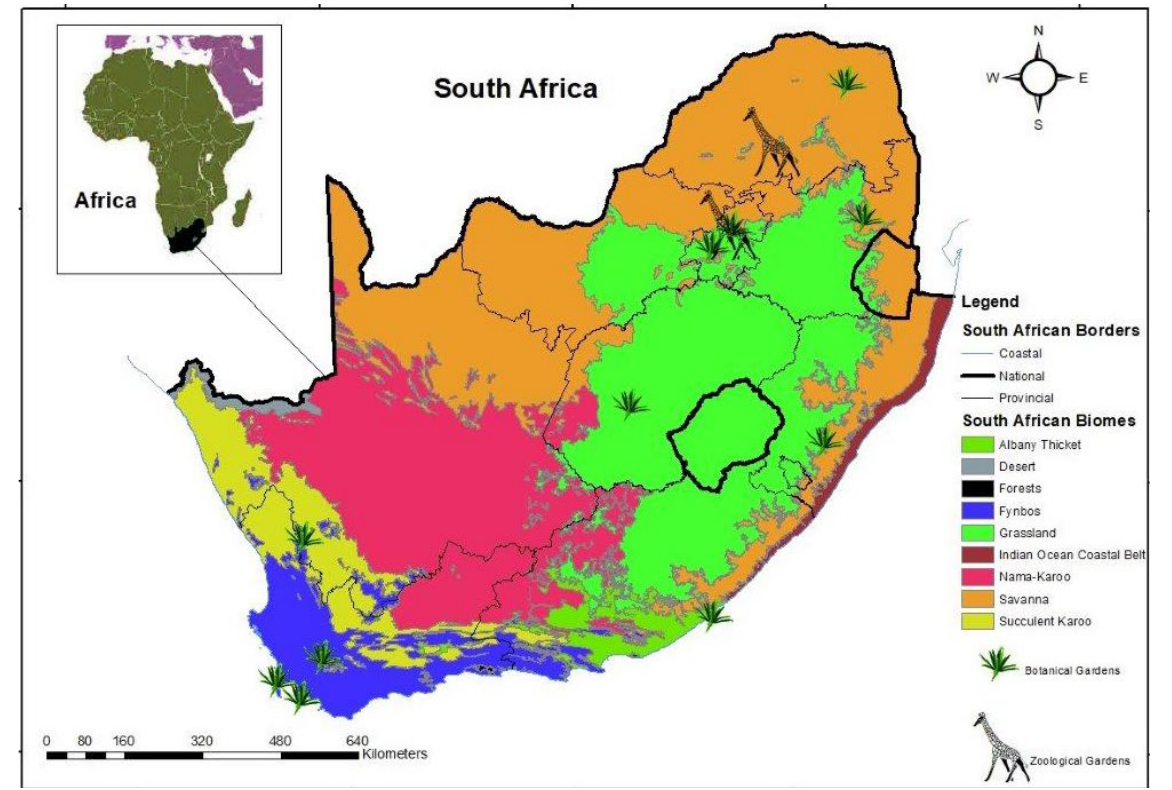
Figure 1. The locations of the SANBI botanical and zoological gardens overlayed on the national vegetation map of South Africa (i.e., vegetation layers from Mucina and Rutherford [22]). Table 1. SANBI botanical and zoological gardens’ features: area, the first date of current land use/proclaimed, biomes and preserved vegetation types.